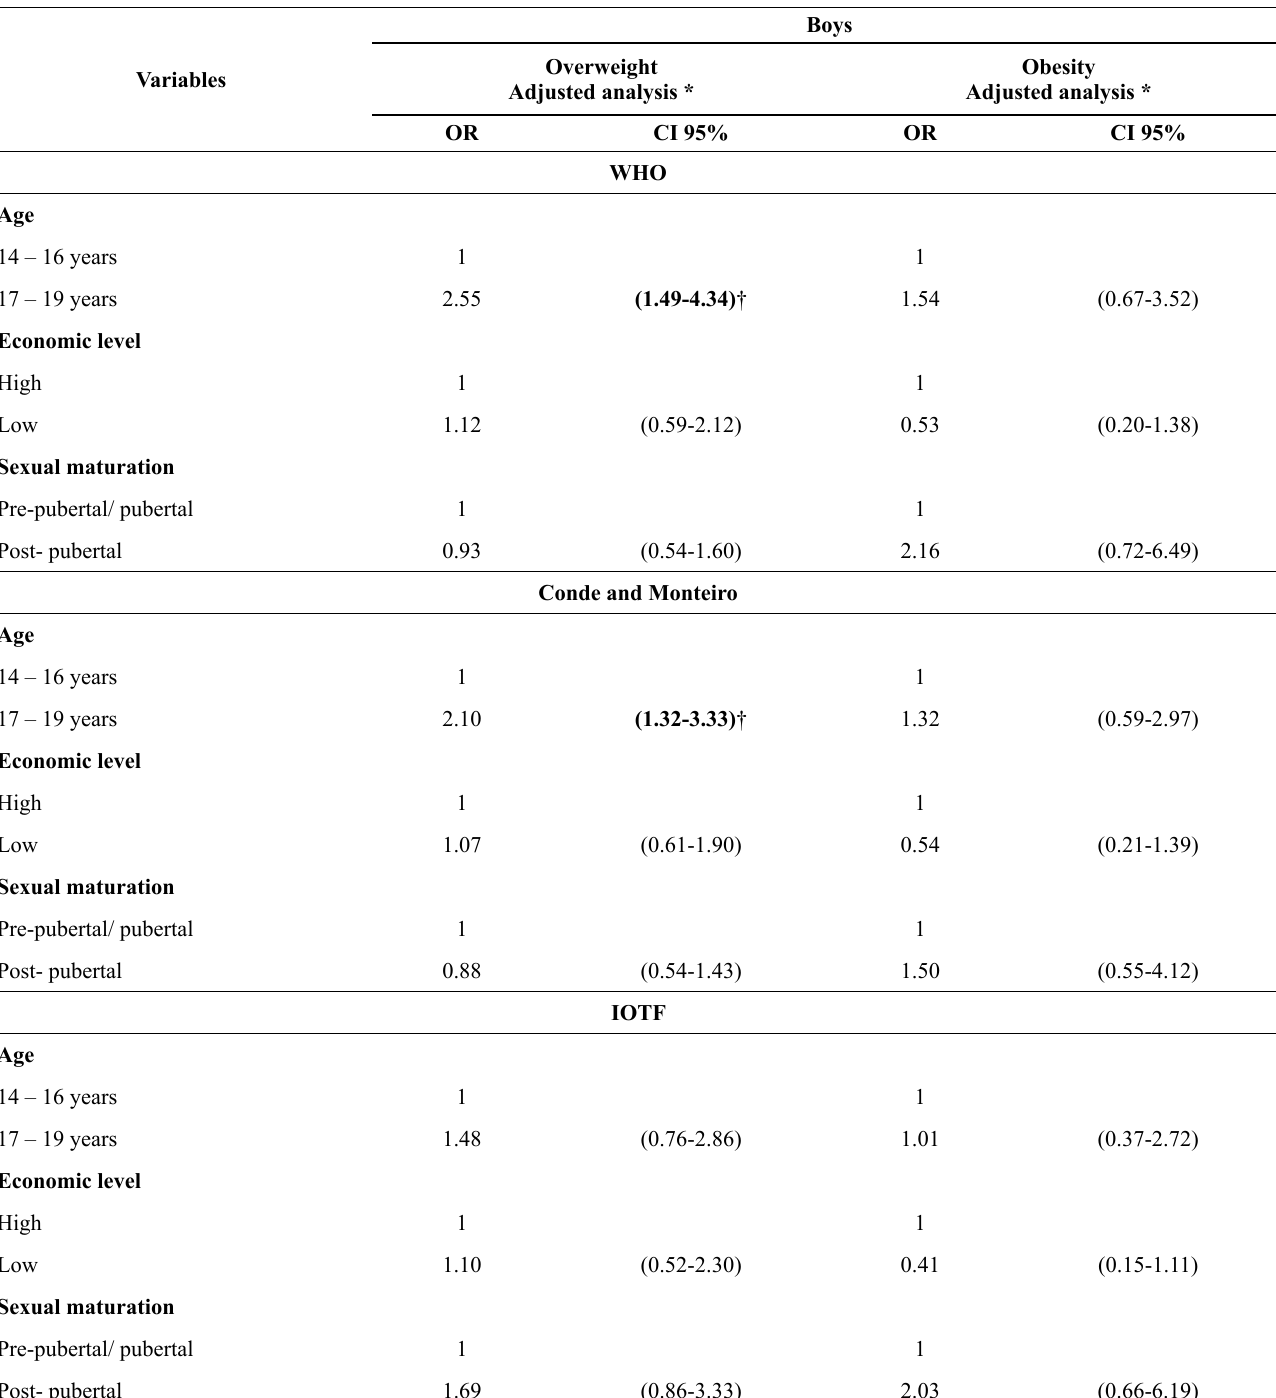
Table 3. Adjusted multinomial regression analysis between socio-demographic factors, sexual maturation and overweight and obesity according to the three classification criteria for boys (n = 519, São José, Santa Catarina,